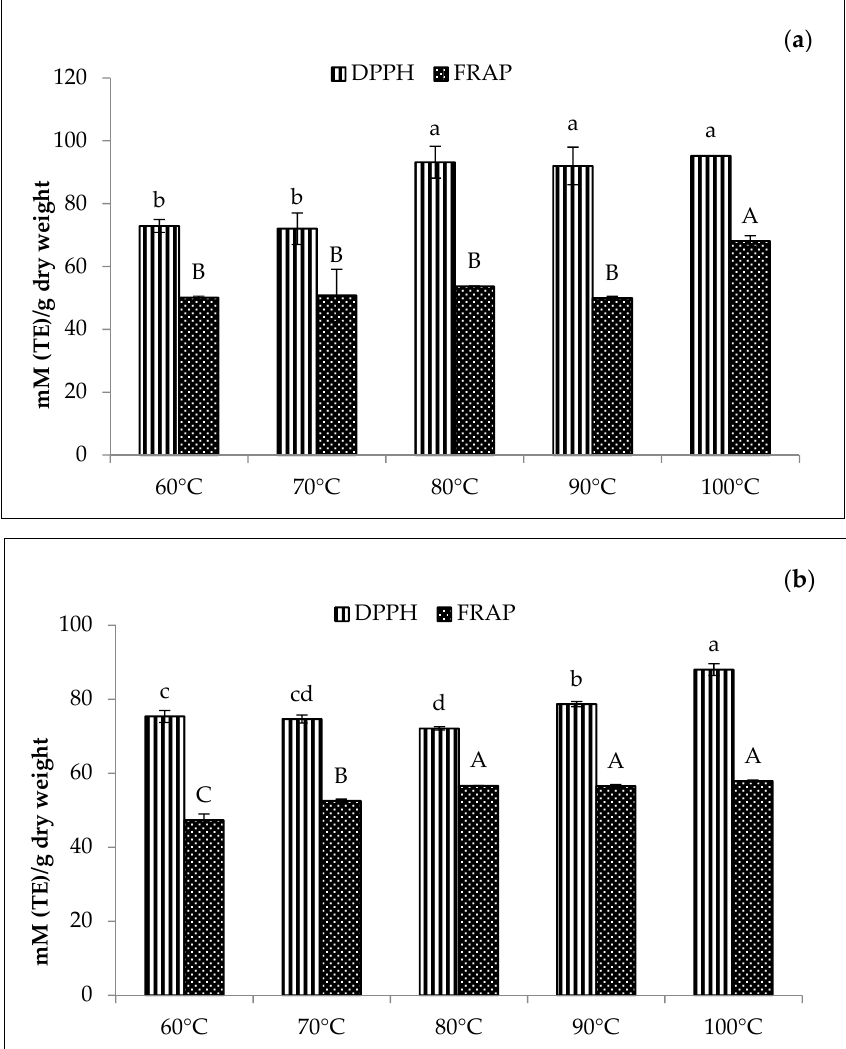
Figure 8. Effect of temperatures for the reaction time of 15 min on antioxidant activities of ( a ) 210 mg/L of CuSO 4 stabilised amaranth purees at pH 6 and ( b ) 1500 mg/L of ZnCl 2 stabilised amaranth purees at pH 8. Each value was expressed as mean ± standard deviation ( n = 3) of triplicate analysis. The bars with different lowercase (a–d) and uppercase (A–C) letters indicate significant differences ( p < 0.05) in Tukey’s HSD test.